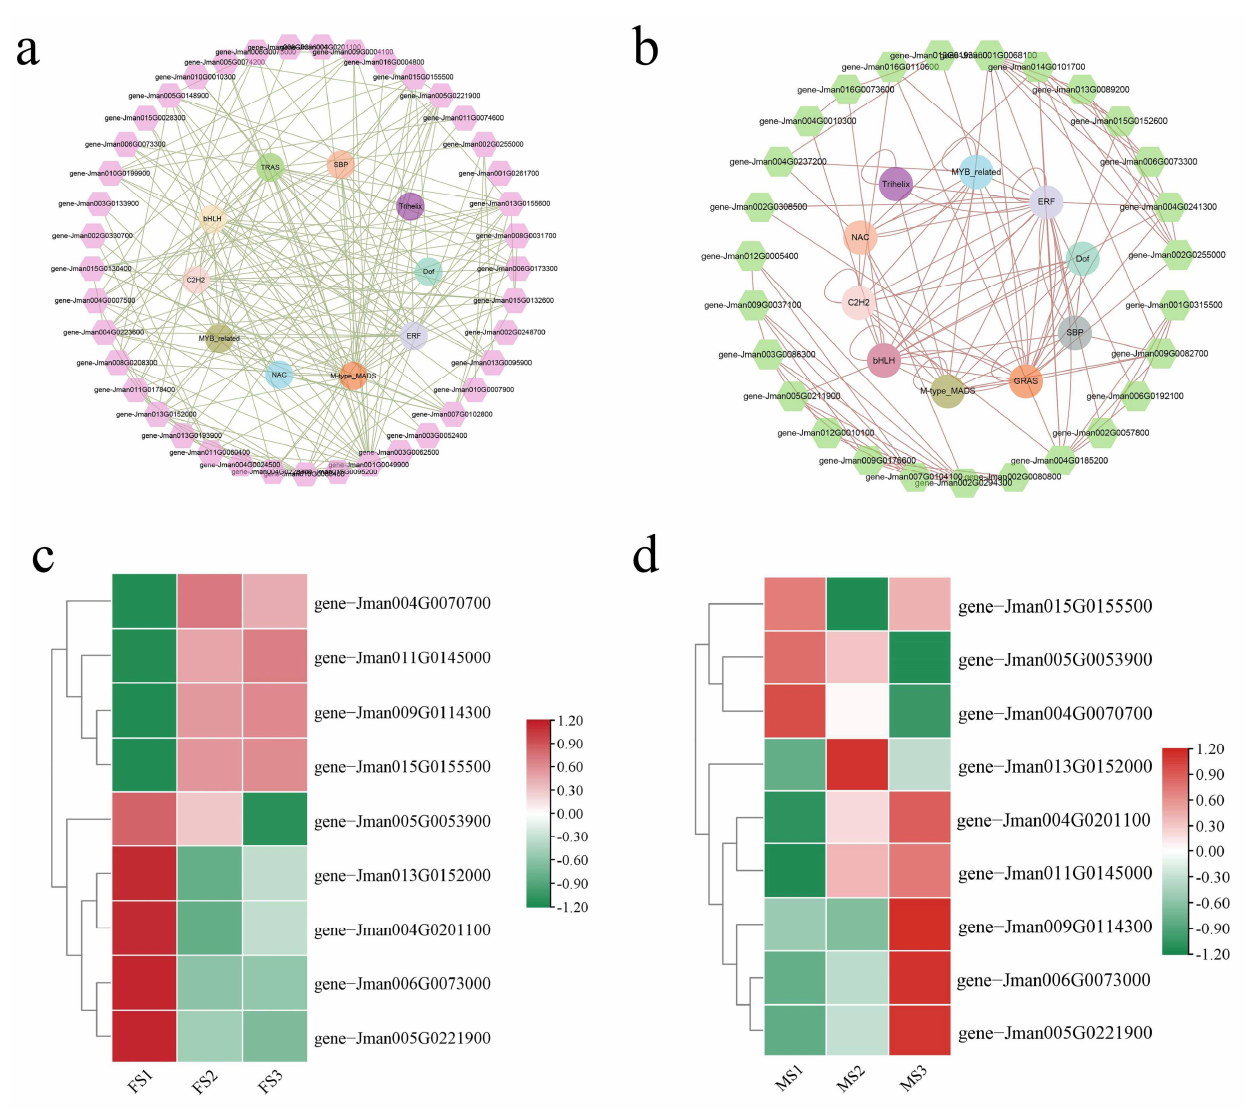
Figure 10. Co-expression network of identified TFs and genes, and the expression pattern of MADS-box genes. ( a ) the co-expression network between TFs and the floral transition and flowering-related genes; ( b ) the co-expression network between TFs and the phytohormone-related genes; ( c ) the expression level of M-type MADS during female flower development; ( d ) the expression level of M-type MADS during male flower development.